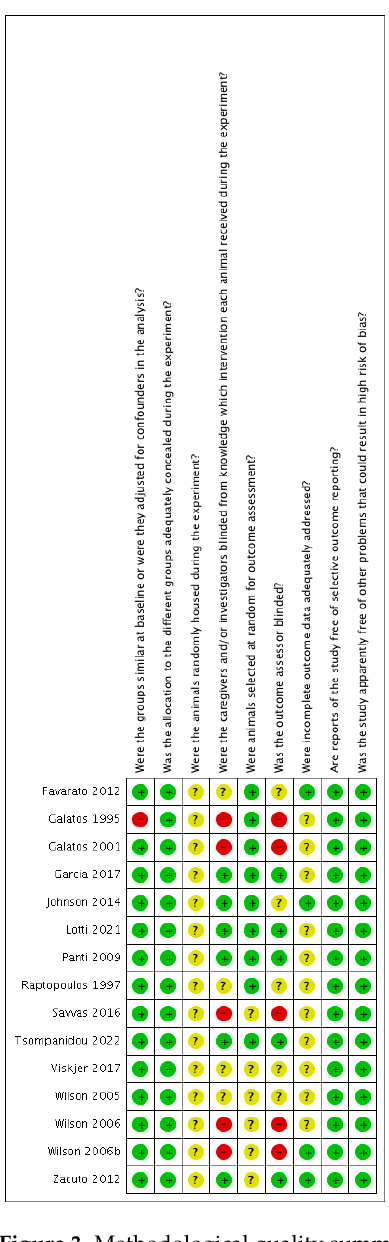
Figure 2. Methodological quality graph: review authors’ judgements about each methodological quality item presented as percentages across all included studies.